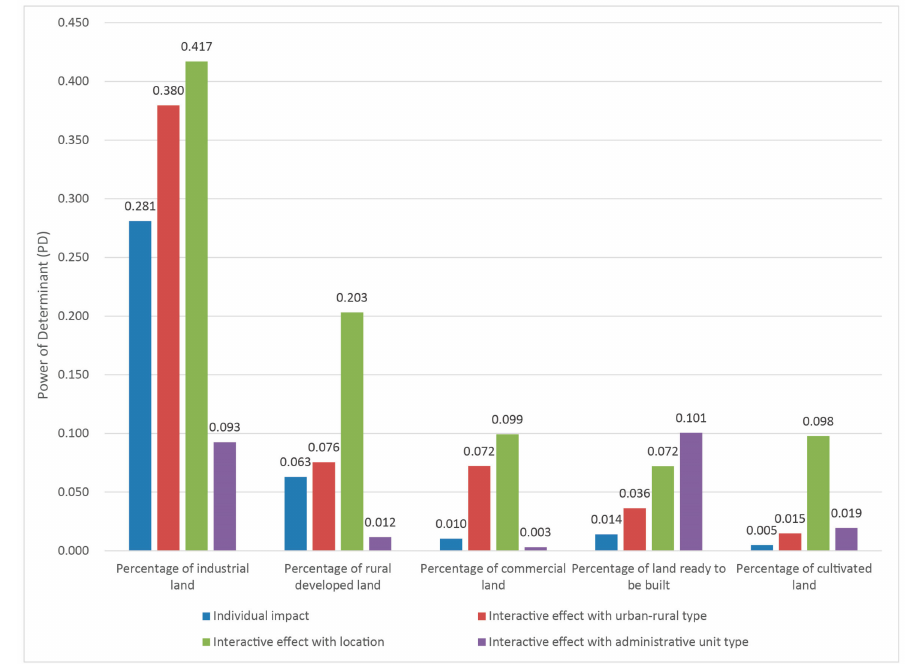
Figure 6. Interactive impact of percentage of land use and urban-rural type, location and administrative unit type on lung